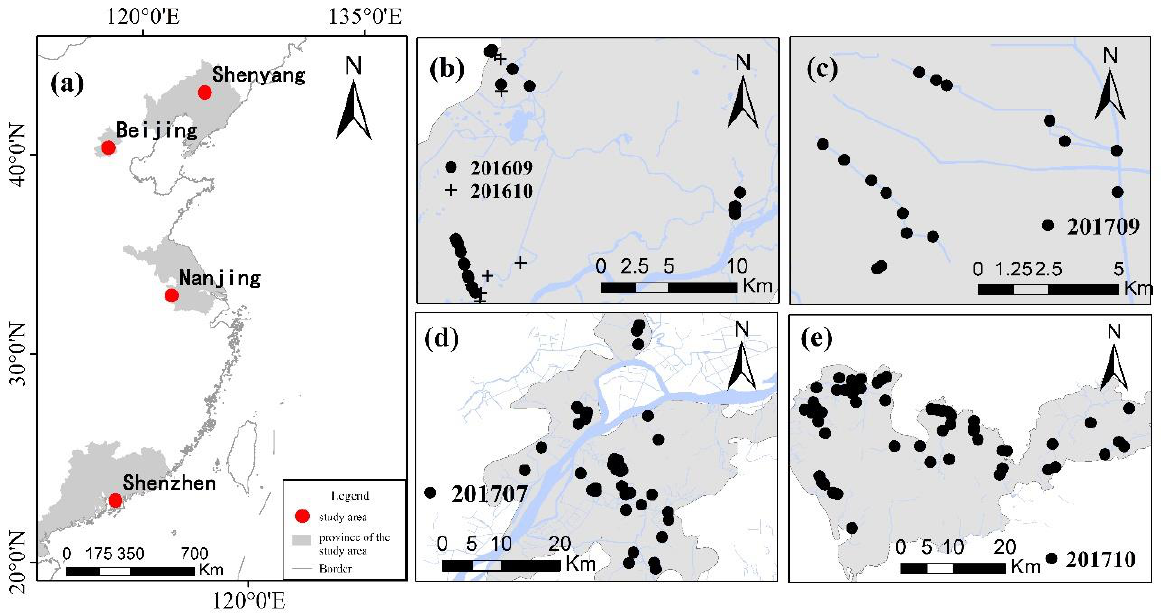
Figure 1. Study area and distribution of sampling points. ( a ): geographical distribution of the study area; ( b – e ): grey areas represent the urban areas of Shenyang, Beijing, Nanjing, and Shenzhen city, respectively; blue indicates urban rivers. Table 3. Date and number of sampling points.